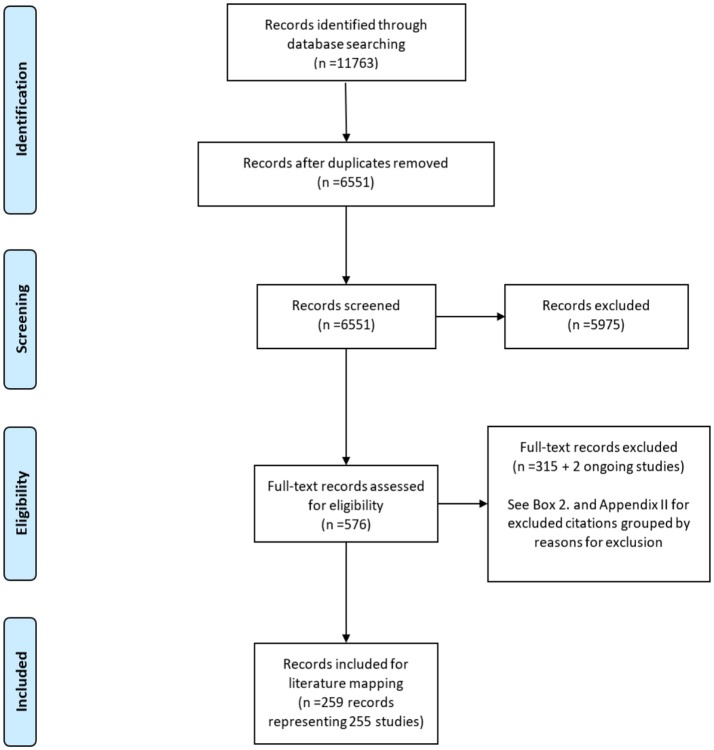
PRISMA flow diagram.